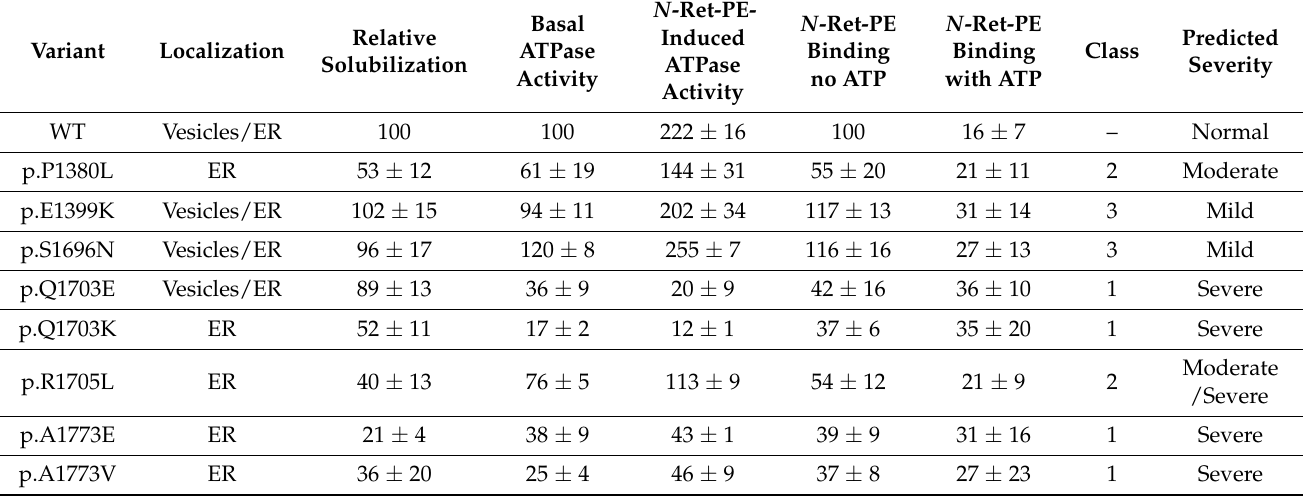
Table 2. Summary of biochemical analysis of TMD2